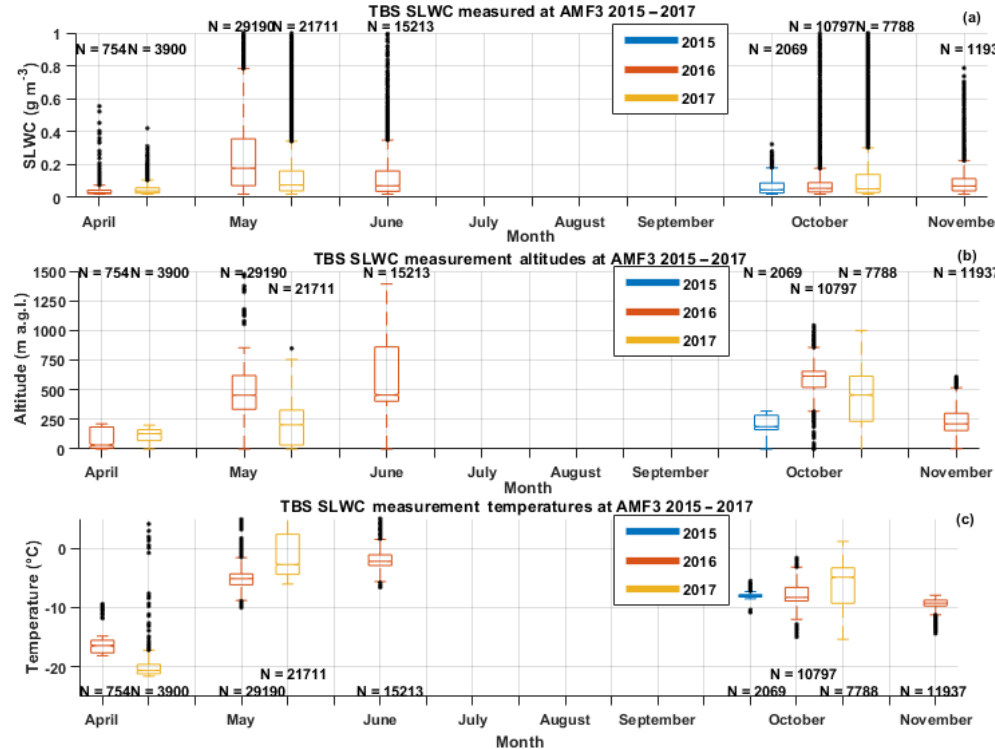
Figure 13. SLWC measured by Anasphere sondes flown on the TBS and SLWC measurement altitudes and temperatures by month from 2015 to 2017, where N refers to the number of SLWC measurements and the median is shown by the horizontal line. The 25th and 75th percentiles are shown by the bottom and top edges of the box, the whiskers extend to the data points not considered outliers, and outliers are plotted with “ +